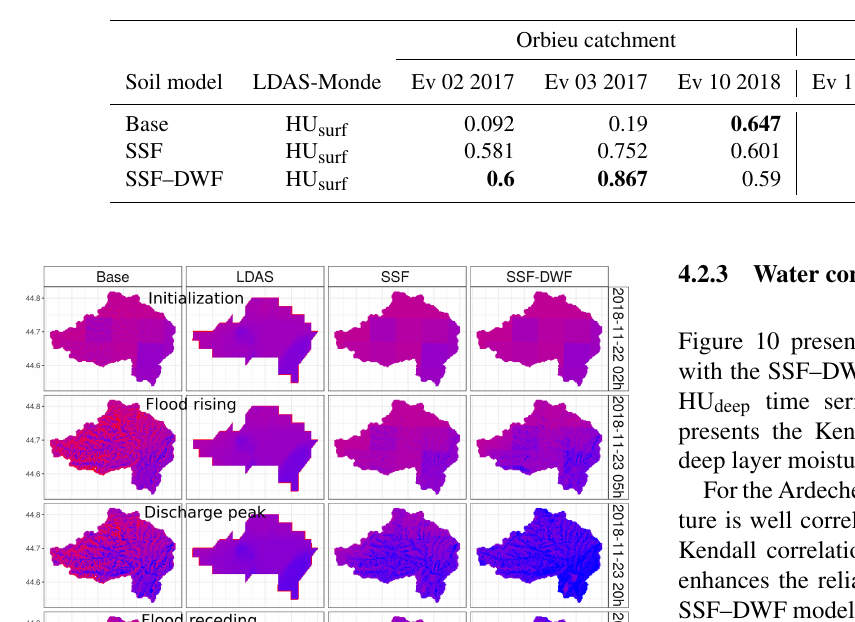
Table 6. Kendall correlations between LDAS-Monde HU surf and MARINE SSD, on average per catchment, for each soil model. The values in bold are the best correlations between the MARINE outputs and the LDAS-MONDE HU surf for each event.